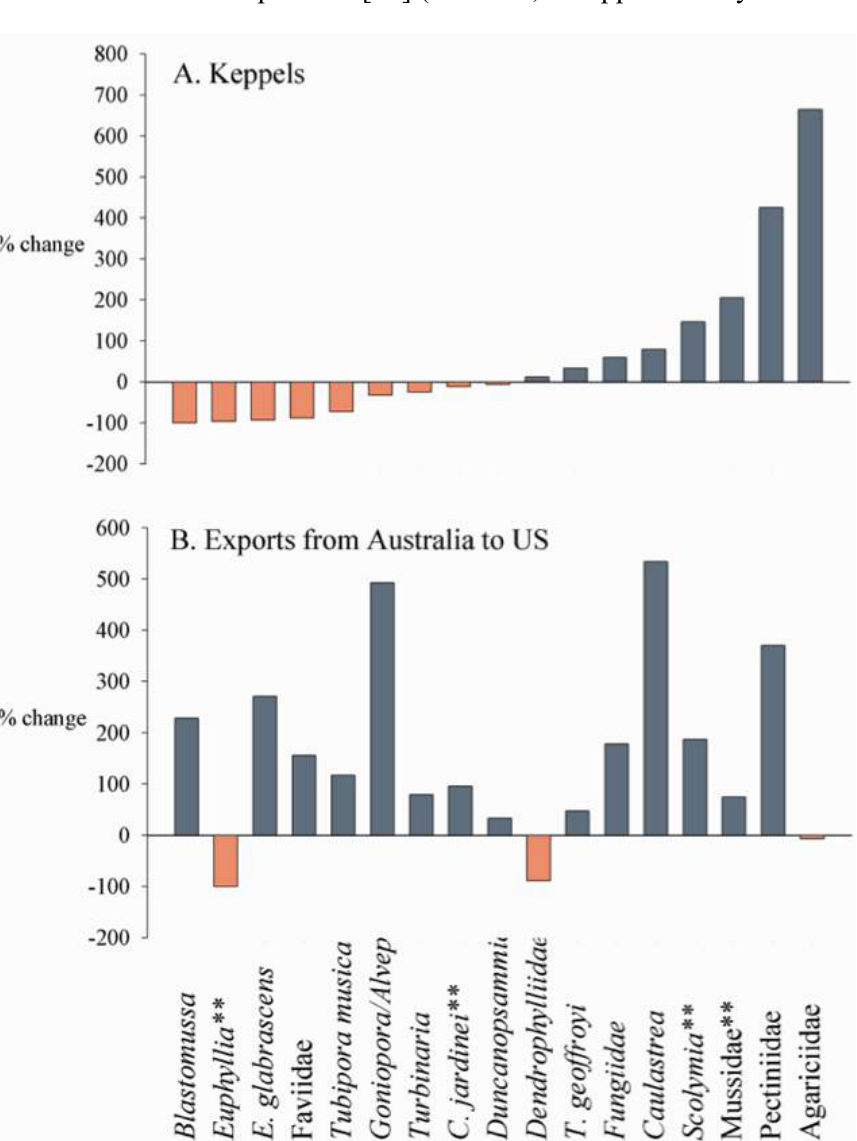
Figure 3. Percentage change in ( A ) the number of specialty coral specimens collected in the Keppel Islands region and ( B ) exported from Australia to the US between 2006/08 and 2008/09. Bars represent the percentage change in harvest for 2008/09 compared to the average for 2006/07–2007/08. Data were sourced from the Fisheries Queensland CFISH database and Convention on the International Trade in Endangered Species (CITES) database respectively. Only a subset of the 28 taxa reported by the Queensland Coral Fishery for the Keppels for which CITES export data were available are shown. Some species of taxa marked with ** are considered as at “remote but never heard of detectable but minimal risk of localized depletion” [29] (Tables 2, 3 Supplementary